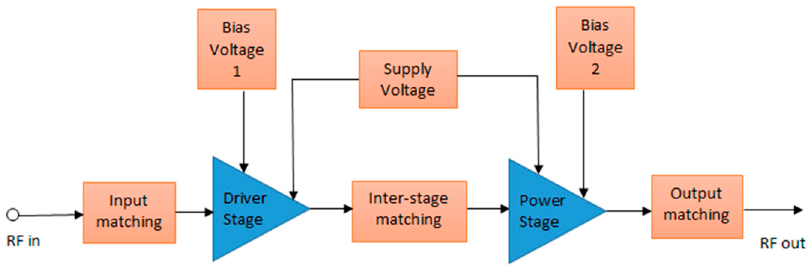
Figure 2. Block diagram of complementary metal–oxide semiconductor (CMOS) power amplifier (PA) [20].